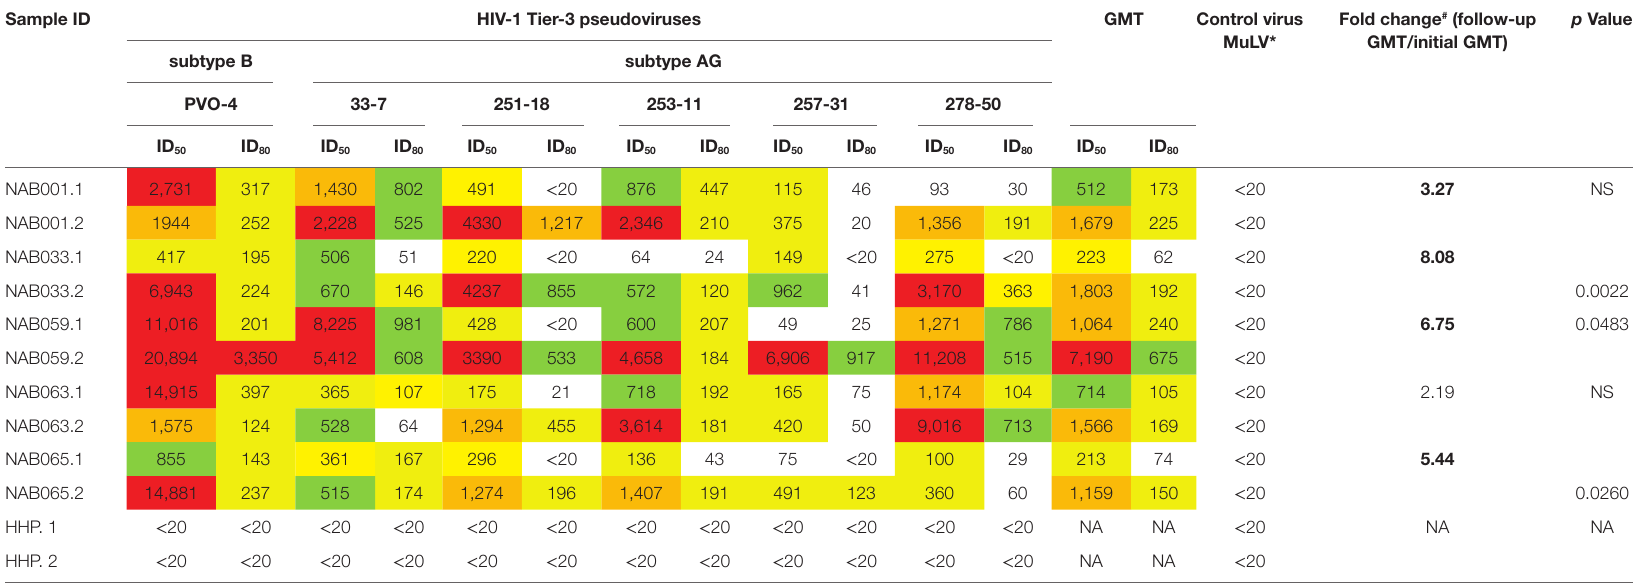
TaBle 2 | Neutralization titration (ID 50 and ID 80 ) analysis of the second-time point plasma samples.